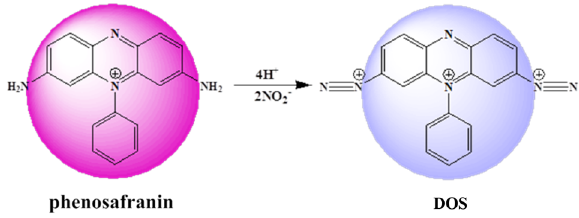
Figure 1. Scheme of proposed sensing platform.